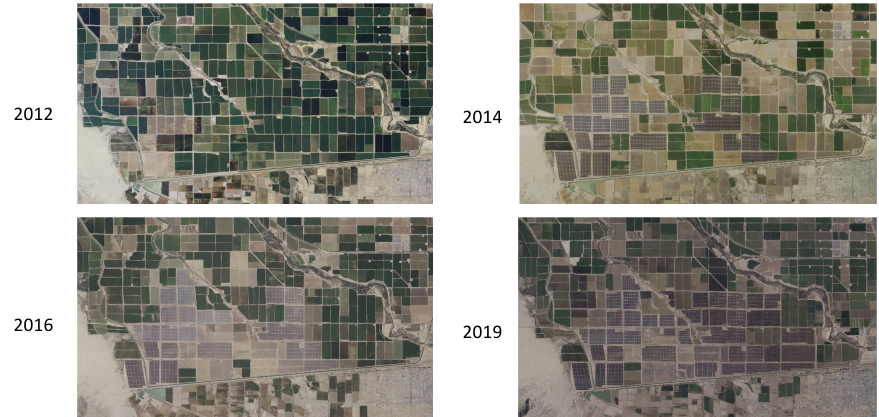
Figure 2. Growth of Mount Signal Solar in Imperial Valley, California, into one of the world’s largest solar farms, over the last decade. Satellite imagery allows for a qualitative and quantitative “big picture” view of solar